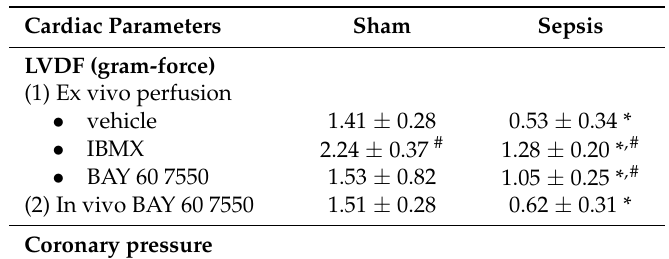
Table 2. Effects of phosphodiesterase (PDE) inhibitors on cardiac contractile function in isolated heart